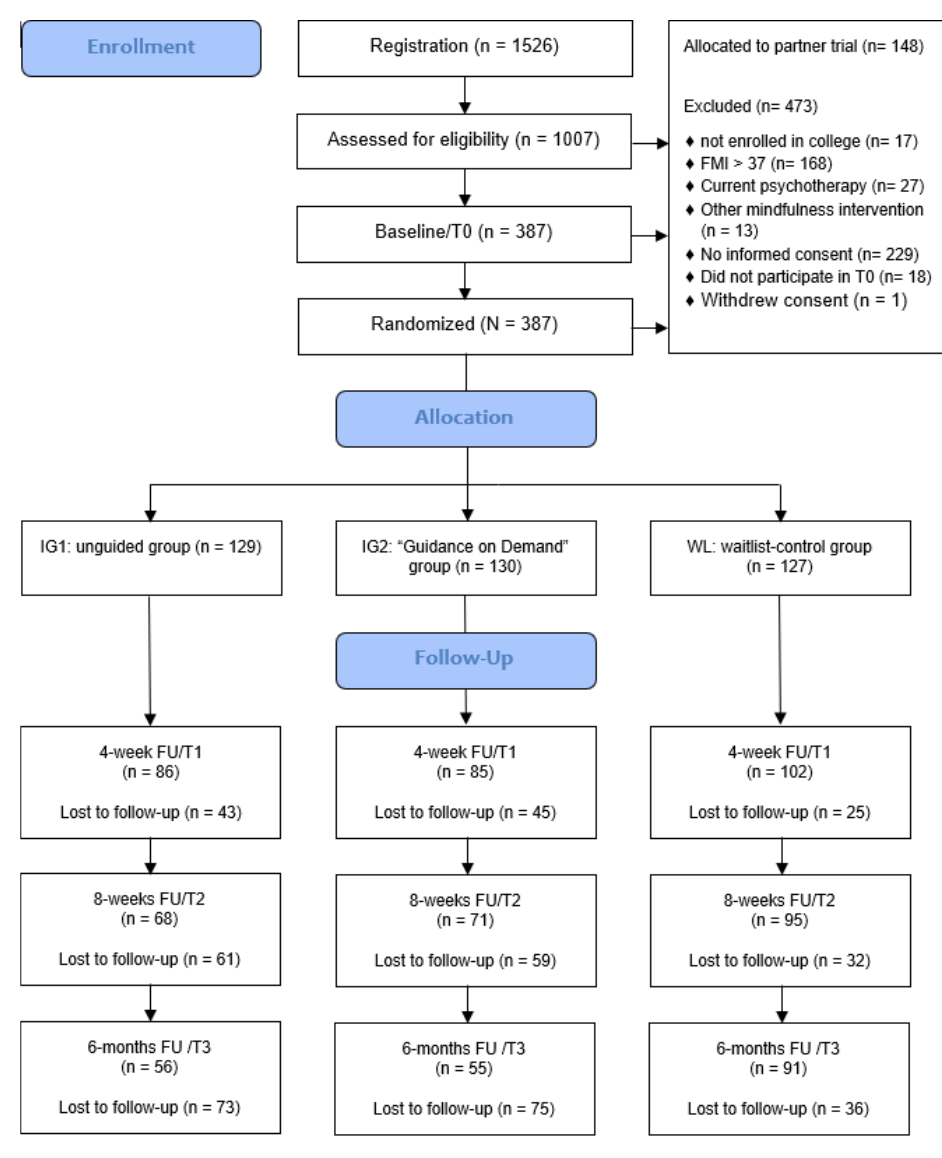
Figure 1. Flowchart. Figure 1.